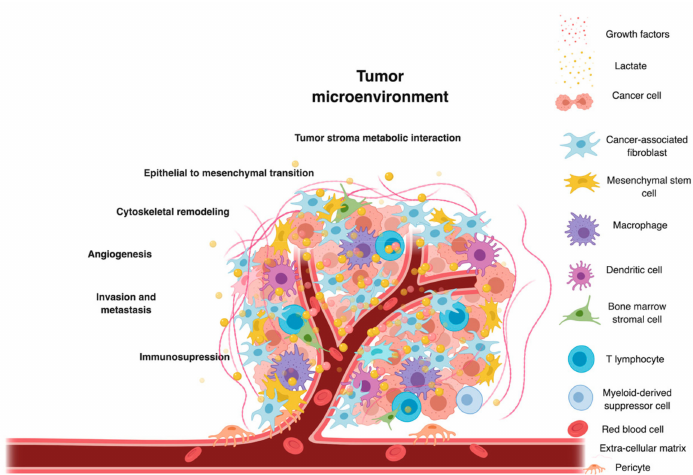
Figure 3. Role of lactate in the tumor microenvironment (TME): A collection of cancer cells with an army of recruited stromal cells, nutrients and growth factors. Metabolic interactions between cancer cells and stromal cells regulate the process of carcinogenesis. One of the primary metabolites through which cancer and stromal cells crosstalk is lactate. Lactate acts as a key player in cancer progression and activates epithelial to mesenchymal transition, cytoskeletal remodeling; promotes immunosuppression and angiogenesis, invasion and